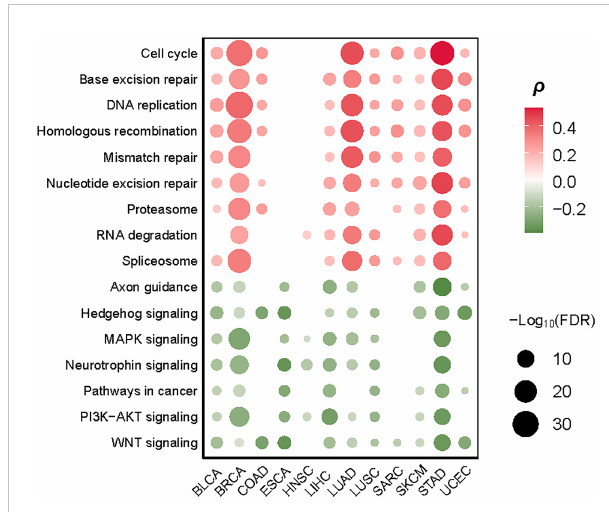
FIGURE 4 Cancer-associated pathways signi fi cantly correlate their activities with TMB in at least eight cancer types. The Spearman ’ s correlation test FDR and correlation coef fi cients ( r ) are